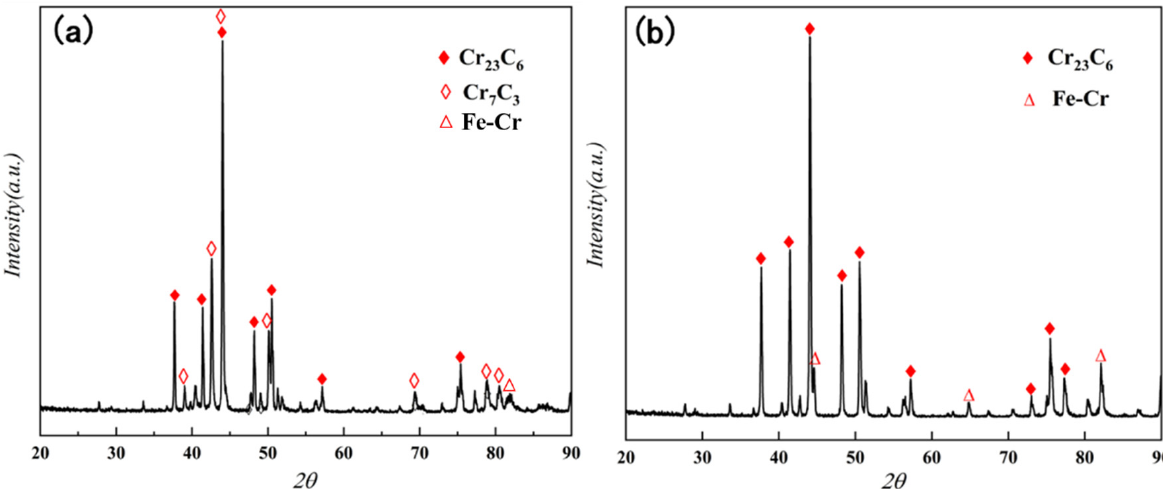
Figure 2. Surface XRD patterns of ( a ) chromized T9 steel and ( b ) chromized SPCC steel.